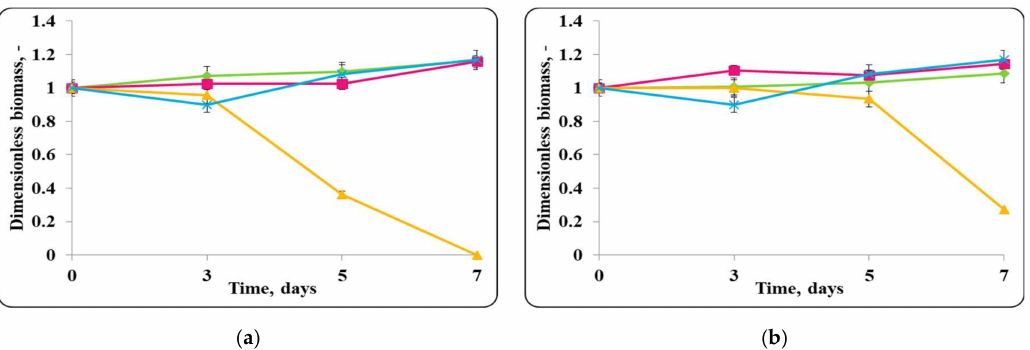
Figure 12. ( a ) free lactobacilli cells; ( b ) encapsulated lactobacilli cells. Changes in the dimensionless biomass of Lb. helveticus 2/20 and S. aureus ATCC 25923 in chocolate mousse at 20 ± 2 ◦ C. Legend: Green (cid:117) : Lb. helveticus 2/20 population following its inoculation; Pink (cid:4) : Lb. helveticus 2/20 population following its co-inoculation with S. aureus ATCC 25923; Blue × : S. aureus ATCC 25923 population following its direct inoculation; Yellow (cid:78) : S. aureus ATCC 25923 population following its co-inoculation with Lb. helveticus